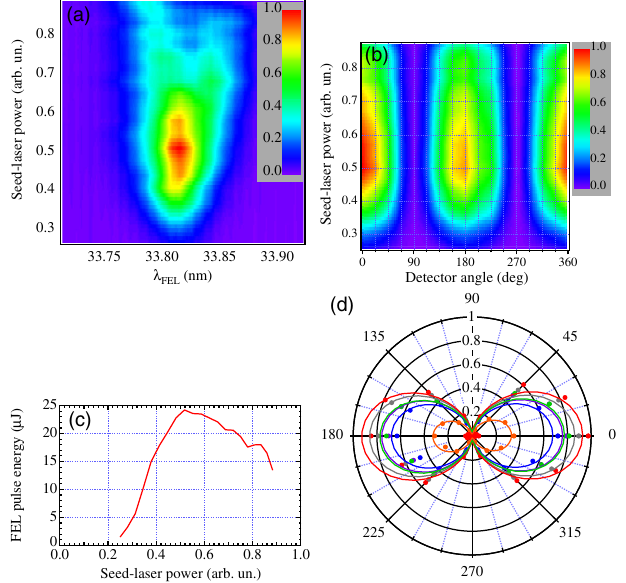
FIG. 11. Evolution of FEL and polarization as a function of the seed-laser power: (a) FEL spectrum, (b) average signal measured by the 16 e-TOF, and (c) FEL energy per pulse as a function of the seed-laser power. Panel (d) reports the polar plot of 16 e-TOF average signals for a few seed-laser intensities and shows that the angular distribution of the signal over the 16 detectors is essentially maintained at all seeding intensities.